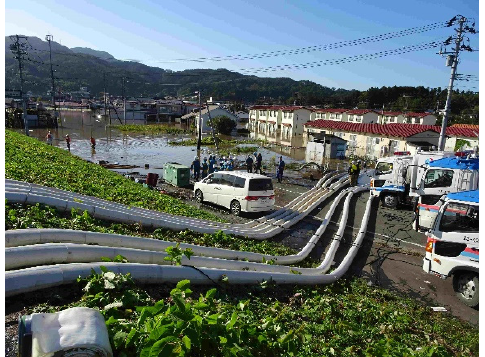
Figure 10. Pumping system for the drainage of the inundation water to the Shin River (photo was taken on 13 October 2019).